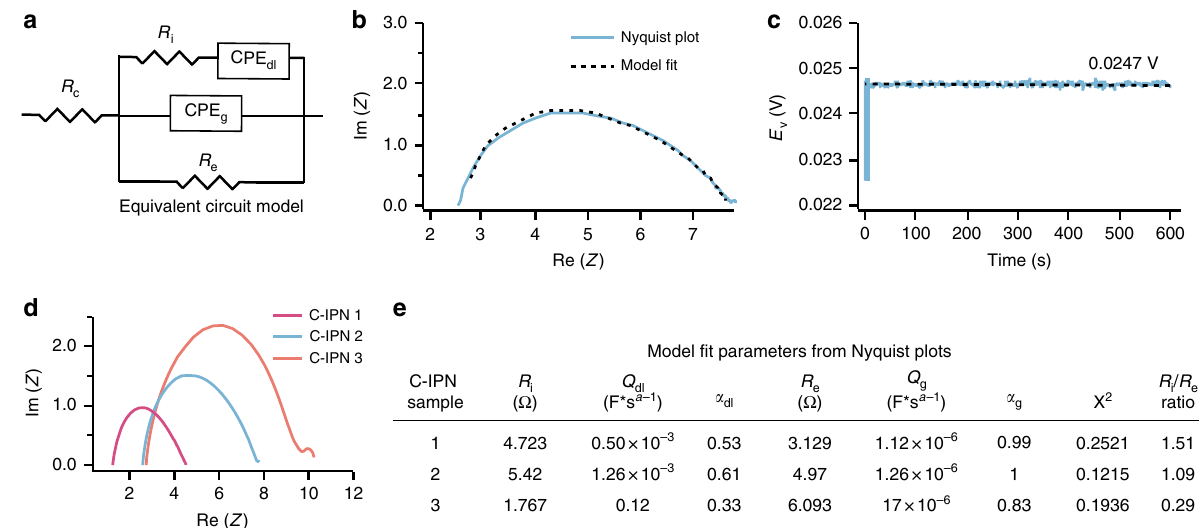
Fig. 4 Characterization of dual ionic and electronic conductivity. a Equivalent circuit model representing the bulk C-IPN hydrogel. R e represents electronic resistance, R i represents ionic resistance, CPE dl represents the double-layer capacitive phase element (CPE), whereas CPE g represents the geometric CPE. CPE elements are used to account for inhomogeneous or imperfect capacitance, and are represented by the parameters Q and α , where Q is a pseudocapacitance value and α represents its deviation from ideal capacitive behavior. The true capacitance ( C ) can be calculated from these parameters by the relationship C = Q ω max α -1 , where ω max represents the frequency at which the imaginary component reaches a maximum 43 . R c represents the total ohmic resistance of the cell assembly. b Nyquist plot obtained from performing electrochemical impedance spectroscopy (EIS) through a bulk C-IPN 2 gel, overlaid with the plot predicted from the equivalent circuit model. Impedance was measured between 500 mHz and 7 MHz, with higher real components of the impedance obtained at lower frequencies. c When a constant DC current of 5 mA is applied through the C-IPN 2 gel, the voltage across the gel plateaus to a value of 0.0247 V. This value can be used to calculate an electronic resistance that is comparable to the value of R e extracted from the model. d Overlay of Nyquist plots obtained for three C-IPN formulations, where C-IPN 1 is the stiffest and densest, and C-IPN 3 is the softest and least dense. Impedance was measured between 500 mHz and 7 MHz, with higher real components of the impedance obtained at lower frequencies. e Values for all relevant parameters extracted for the three C-IPN formulations by fi tting their EIS data with the equivalent circuit model. As the gel stiffness and density increase, the relative ionic resistance within the gel increases as